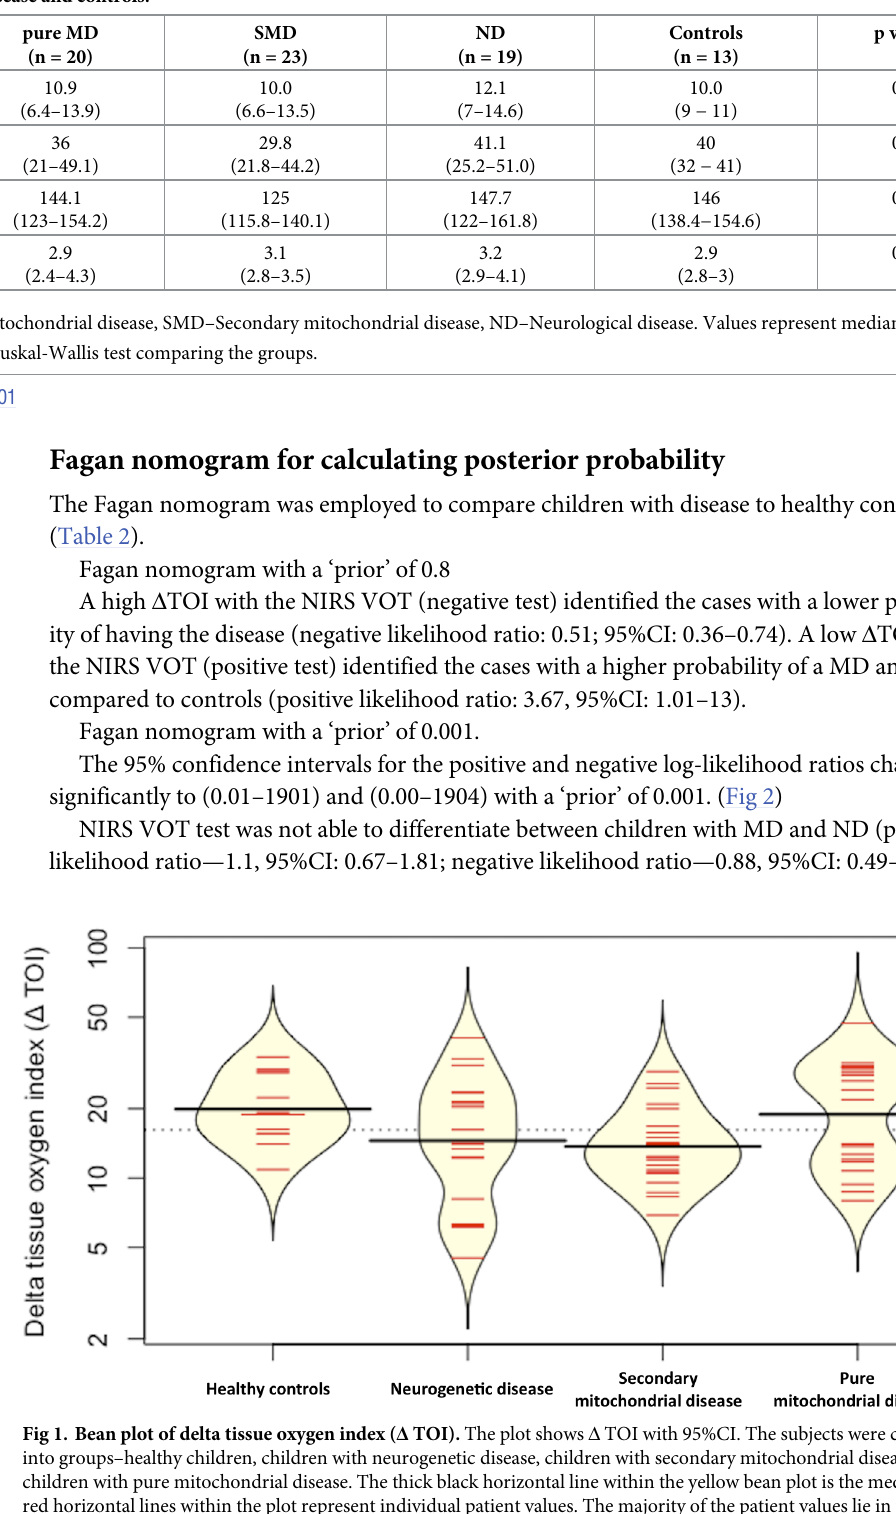
Fig 1. Bean plot of delta tissue oxygen index ( Δ TOI). The plot shows Δ TOI with 95%CI. The subjects were classified into groups–healthy children, children with neurogenetic disease, children with secondary mitochondrial disease and children with pure mitochondrial disease. The thick black horizontal line within the yellow bean plot is the median. The red horizontal lines within the plot represent individual patient values. The majority of the patient values lie in the area where the bean plot is